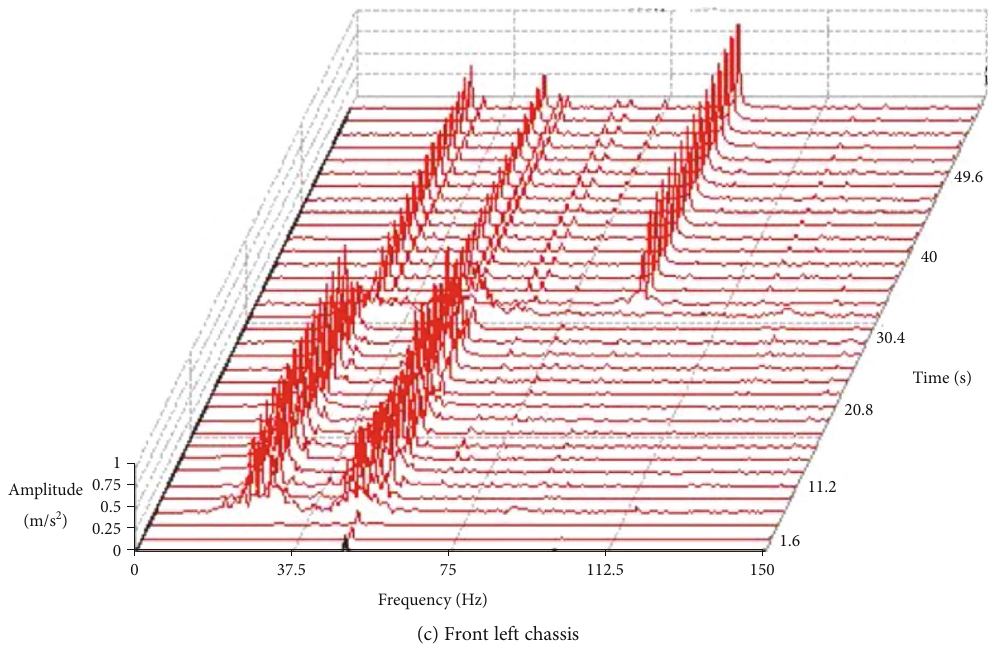
Figure 6: Time-frequency waterfall diagram of each measuring point when the engine is working at a high